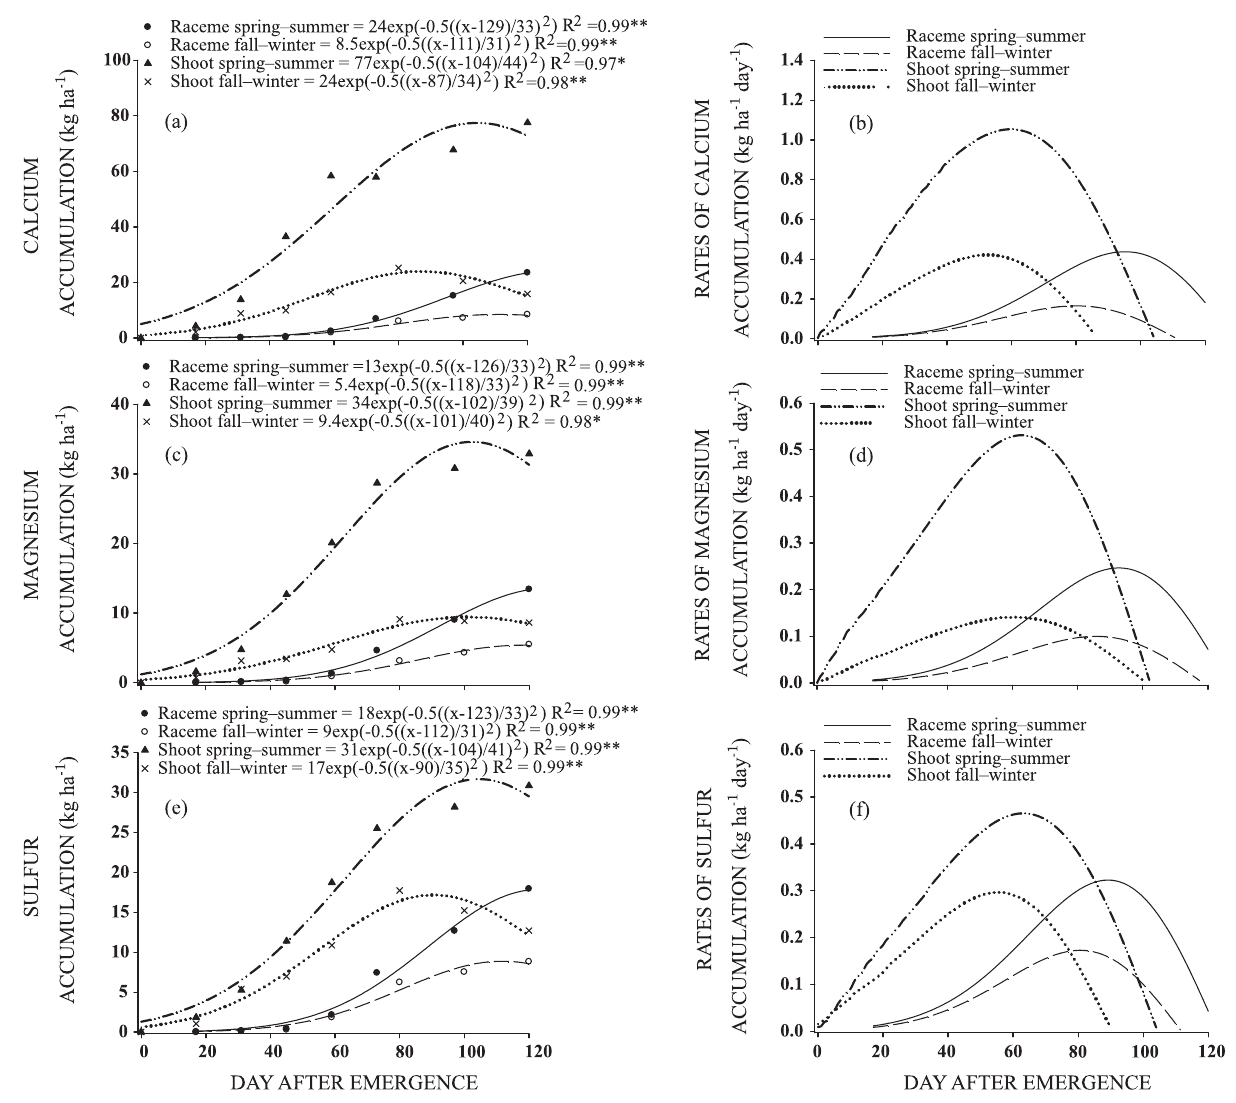
Figure 4. accumulation and accumulation rates of calcium (a and b), magnesium (c and d) and sulfur (e and f) in racemes and shoot of the castor bean hybrid Lyra in the 2005/2006 spring-summer and 2006 fall-winter growing seasons. ** and * are: significant at p ≤ 0.01 and p ≤ 0.05 by the F